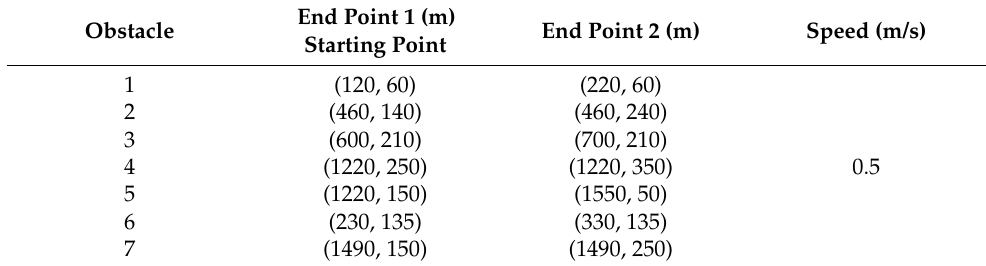
Table 3. Parameters of dynamic obstacles.